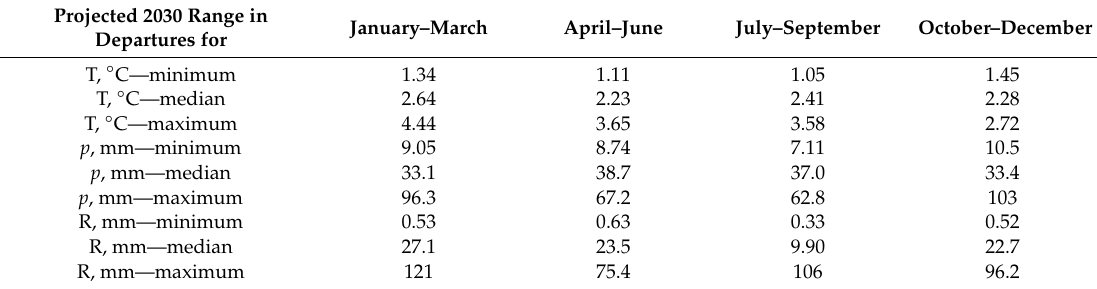
Table 3. Summary statistics for 214 climate simulations of projected 2030 ranges (95th percentile − 5th percentile) of departures in average monthly temperature (T), precipitation ( p ), and runo ff (R) for each season, for the 374 National Park Service